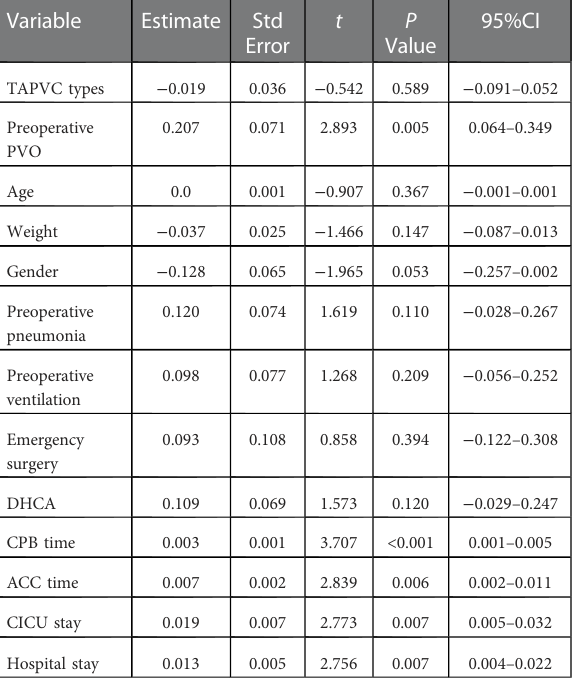
TABLE 3 Simple linear regression analysis of factors associated With postoperative pulmonary vein fl ow acceleration. Variable